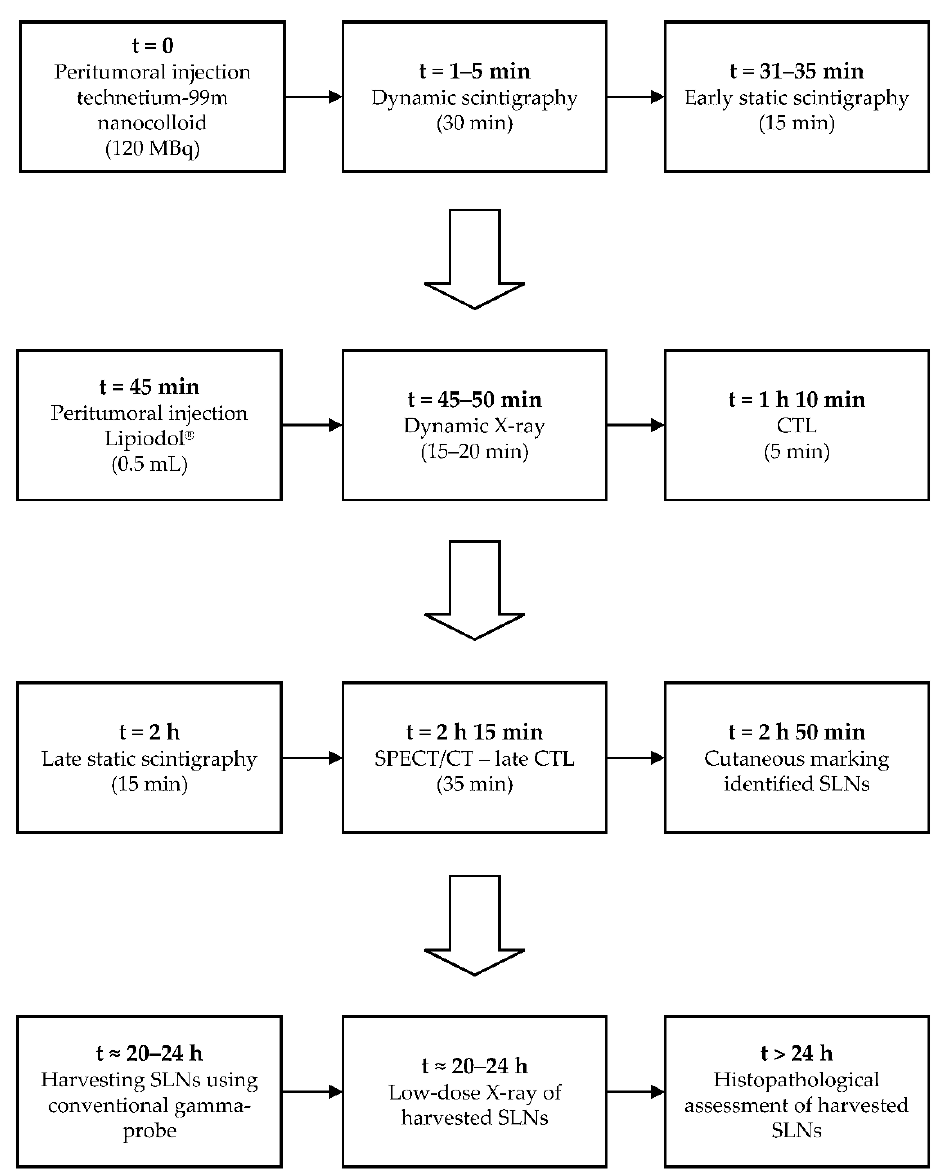
Figure 1. Time schedule of study events. MBq, megabecquerel; mL, milliliter; CTL, computed tomography lymphography; SPECT/CT, single-photon emission computed tomography/computed tomography; SLNs, sentinel lymph nodes.